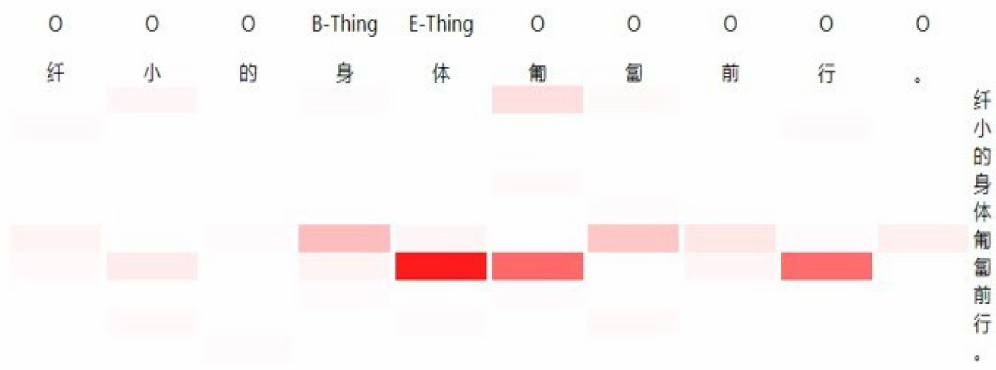
Figure 9. Instance of self-attention visualization